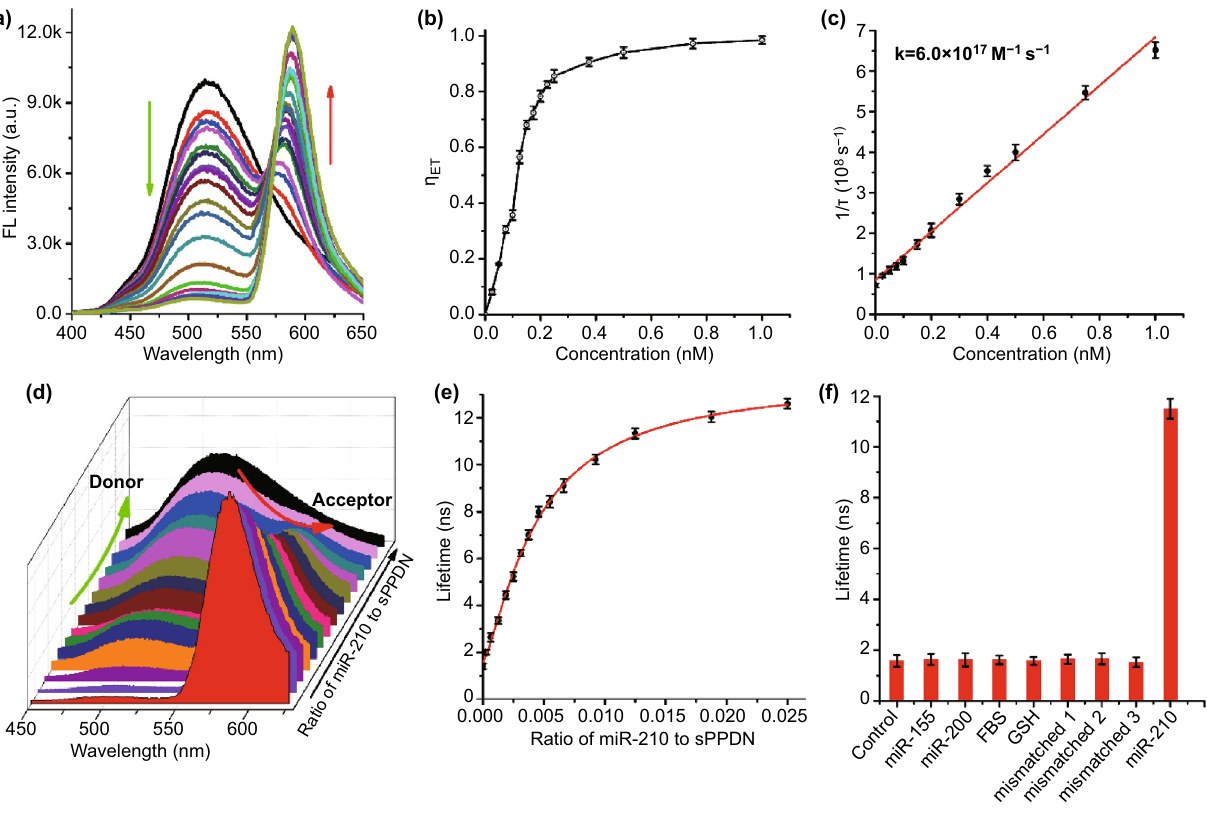
Fig. 2 a Fluorescence spectra of sPPDN (DNS: 1 µM) in aqueous solution with different concentrations of SCO-Rb. The concentrations of SCO-Rb were 0.00, 0.01, 0.025, 5, 0.075, 0.1, 0.125, 0.15, 0.175, 0.2, 0.225, 0.25, 0.5, 0.75, 1 nM. b Energy transfer efficiency as a function of SCO-Rb concentration in sPPDN. c Plots of the reciprocal of the lifetime of the PPDN containing different concentrations of Rb against the concentrations of the acceptors. The slope gives the corresponding second-order rate constant (k) for the excitation energy migration toward the acceptor. Response of sPPDN to the nucleic acid target. d Fluorescence spectra of sPPDN after incubation with target miR-210 with different concentrations. e Fluorescence lifetime of DNS after incubation with the target at different concentrations of miR-210. f Fluorescence lifetime change of sPPDN for miR-210, miR-200, miR-155, FBS, GSH, and the mismatched sequences of